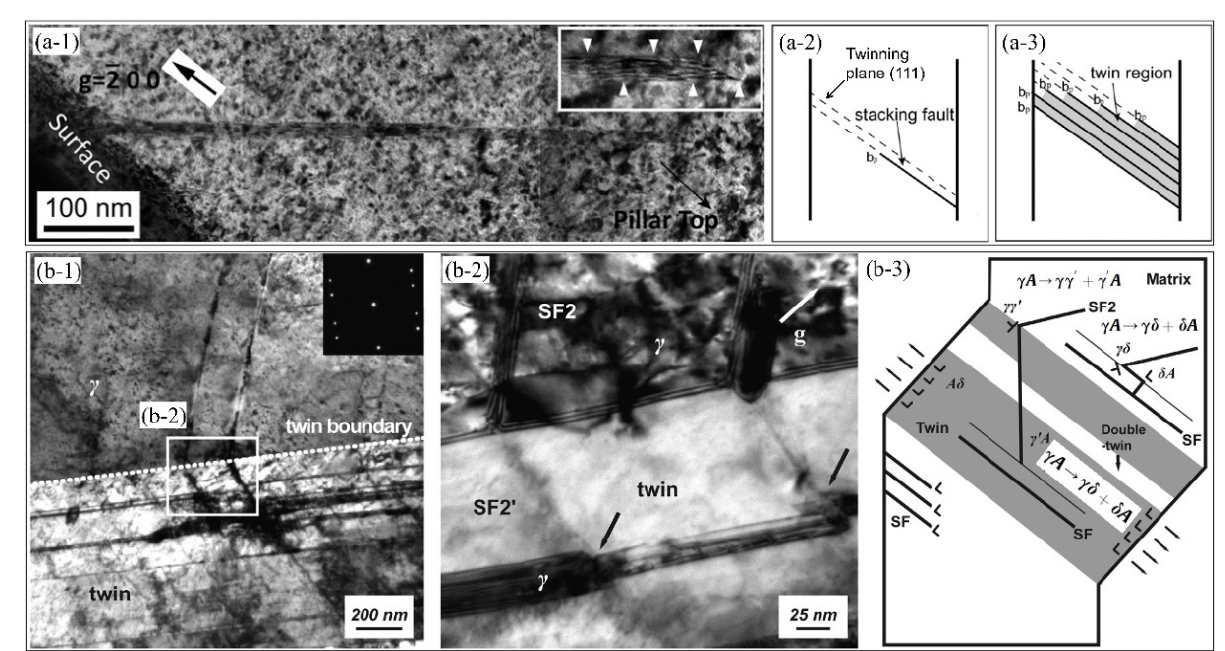
Figure 11. ( a ) The comparison between the simulated stress–strain curves and the one obtained by experiments. The inset shows the formation of twins in the austenitic pillar after the compression test. ( b – d ) The simulated stress–strain curve at different engineering strains together with the cor- responding morphology of deformation twins [70]. The red color in ( b – d ) represents the defor- mation twins. Reprinted with permission from ref. [70]. Copyright 2015, Elsevier.